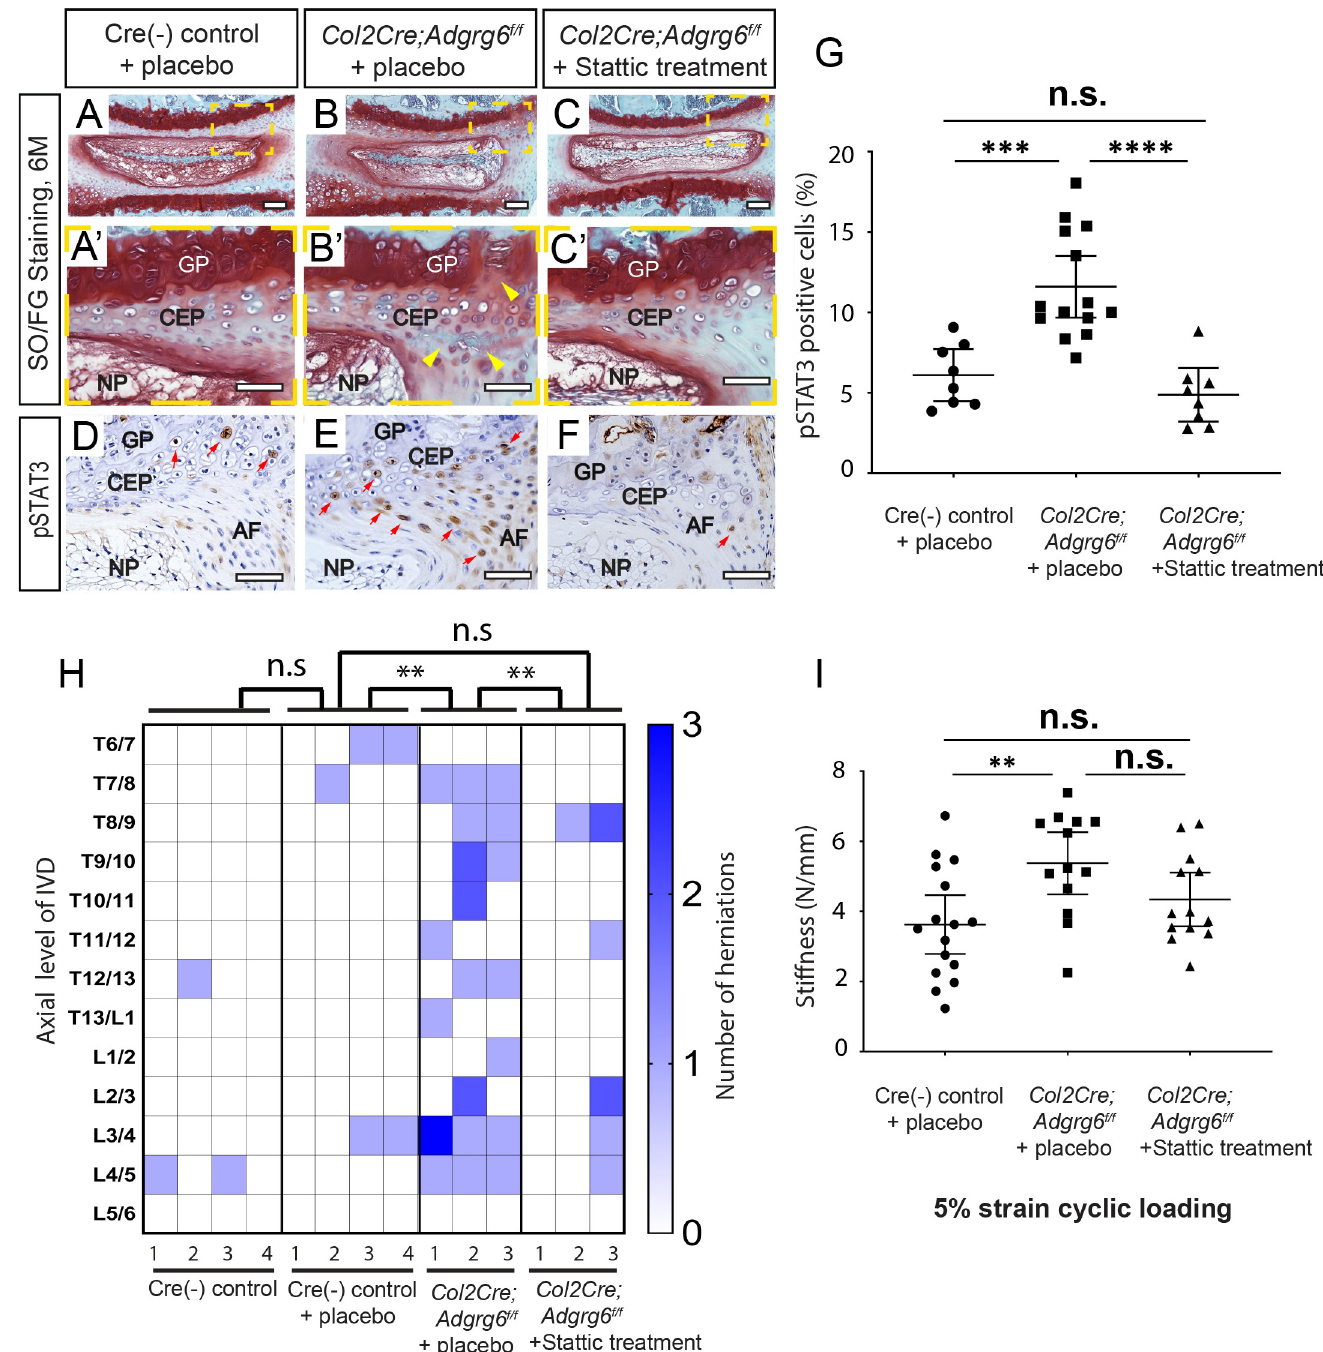
Fig 6. Inhibition of STAT3 by Stattic alleviates the formation of disc herniations and disc stiffness attributed to loss of ADGRG6 function. (A-C’) Representative Safranin-O/Fast green staining and (D-F) pSTAT3 IHC in medial-sectioned mouse IVD from placebo-treated Cre (-) control (A-A’, D), placebo- treated Col2Cre;Adgrg6 f/f mutant (B-B’, E), and Stattic treated Col2Cre;Adgrg6 f/f mutant mice (C-C’, F) by the age of 6 months (A-C’) or 2 months (D-F) ( n = 3 mice for each group). Col2Cre;Adgrg6 f/f mutant mice display defects of the IVD including lesions and clefts in the CEP and GP (yellow arrowheads, B’) and increased, expression of pSTAT3 in CEP and AF (red arrowheads, E), which is reduced by Stattic treatment (C-C’, F). (G) Quantification of positive pSTAT3 cells in Cre (-) control or in Col2Cre;Adgrg6 f/f mutant mice mutant mouse IVDs by the age of two months after two weeks of Stattic treatment. ( n = 3 mice for each group, two to five IVDs were scored for each mouse. Dots plot with mean ± SD. ��� p � 0.001, ���� p � 0.0001, One way ANOVA followed by Tukey HSD test. n.s, not significant.) (H) Heat map to represent contrast-enhanced microCT data from 6-month-old mice from three experimental groups: four placebo-treated Cre (-) controls; three placebo-treated Col2Cre;Adgrg6 f/f mutants; and three Stattic-treated Col2Cre;Adgrg6 f/f mutants. Plotted by the axial level of the IVD (left axis) and the number of